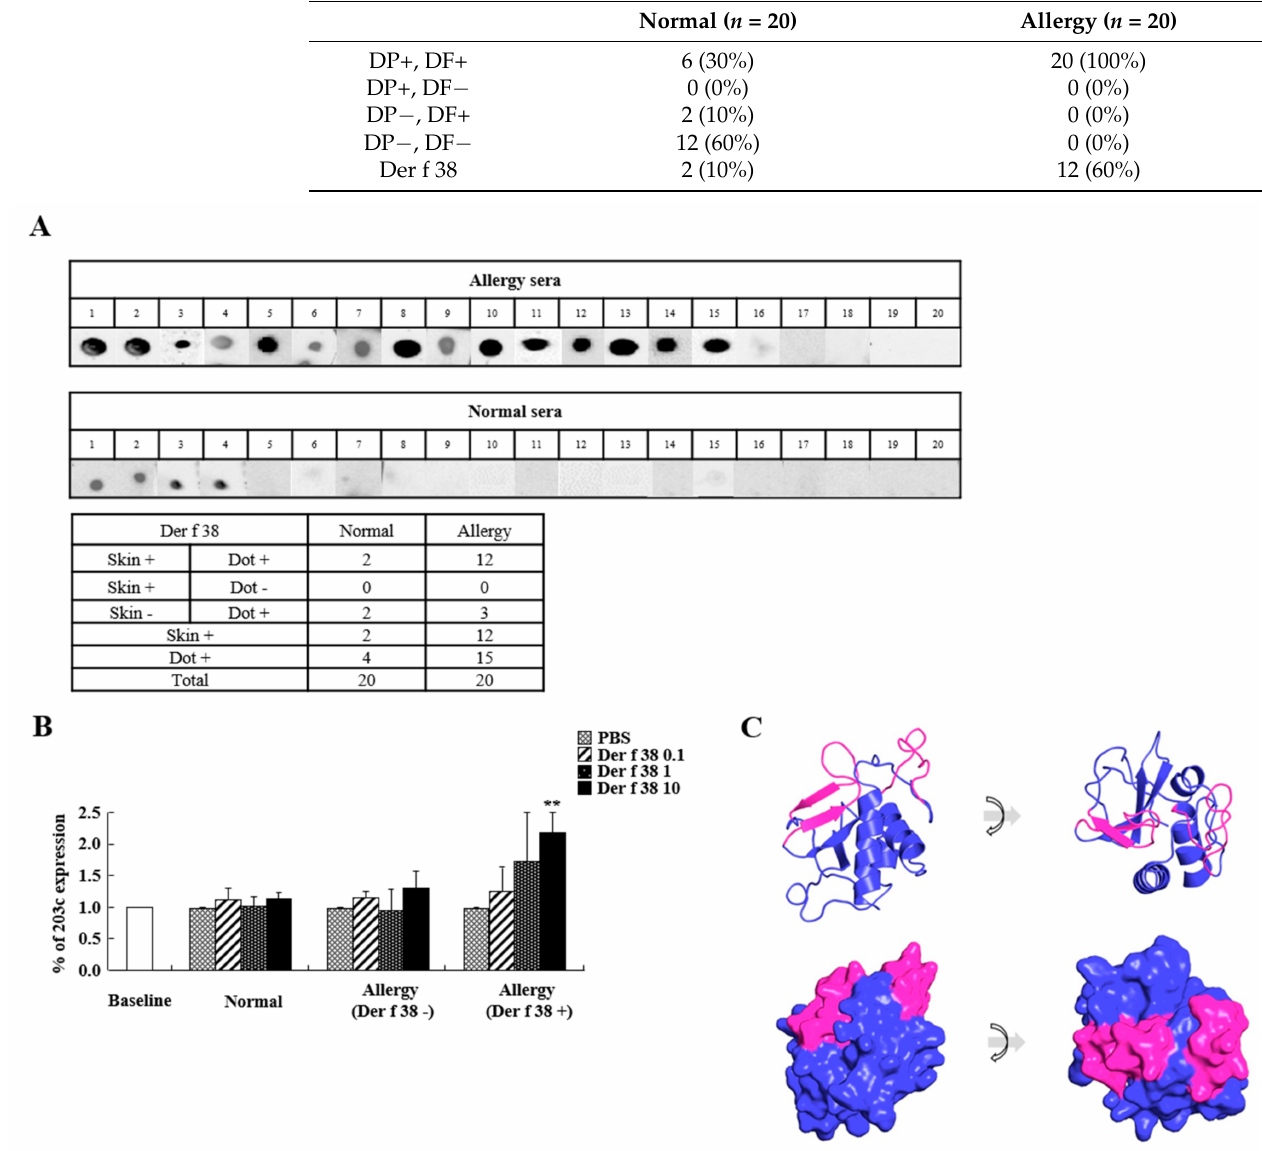
Table 1. The results of the skin prick test.